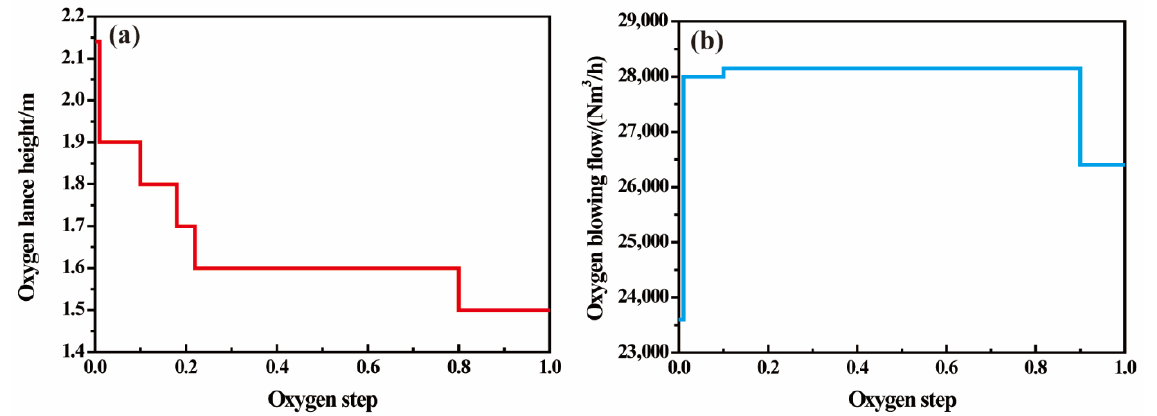
Figure 3. The oxygen blowing process of the 120 t converter. ( a ) Oxygen lance height control curve. ( b ) Oxygen blowing flow control curve.